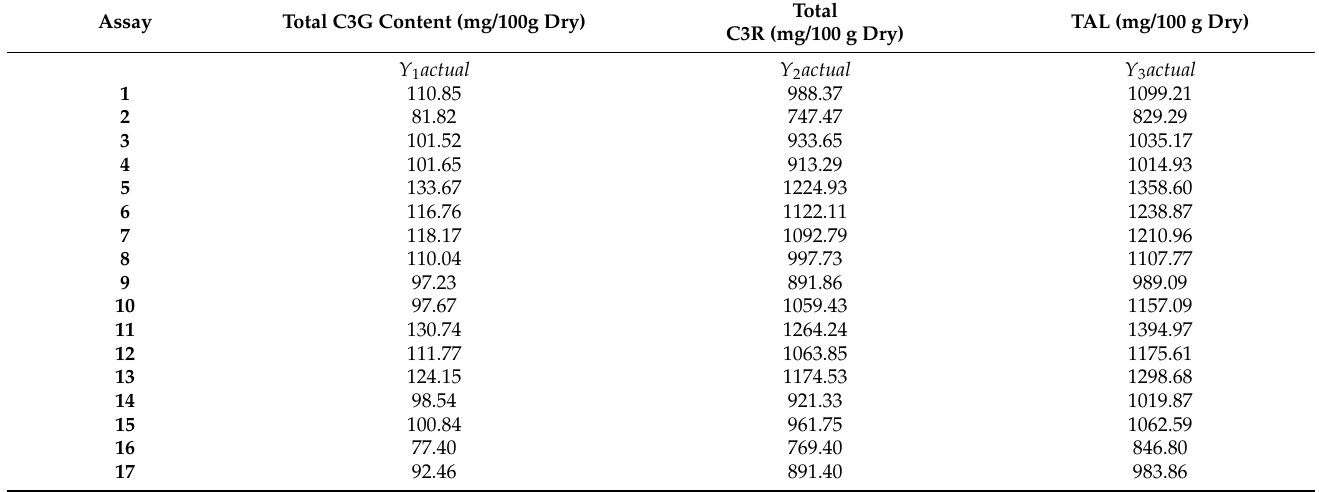
Table 4. Experimental values for C3G, C3R, and TAL obtained from fractional experimental design (2 5-1 ) with three central points for Ch-Xyl and Lp-Gly used as independent variables as well as R (S/L) , extraction repetitions, time, and R (CoSolvt%)